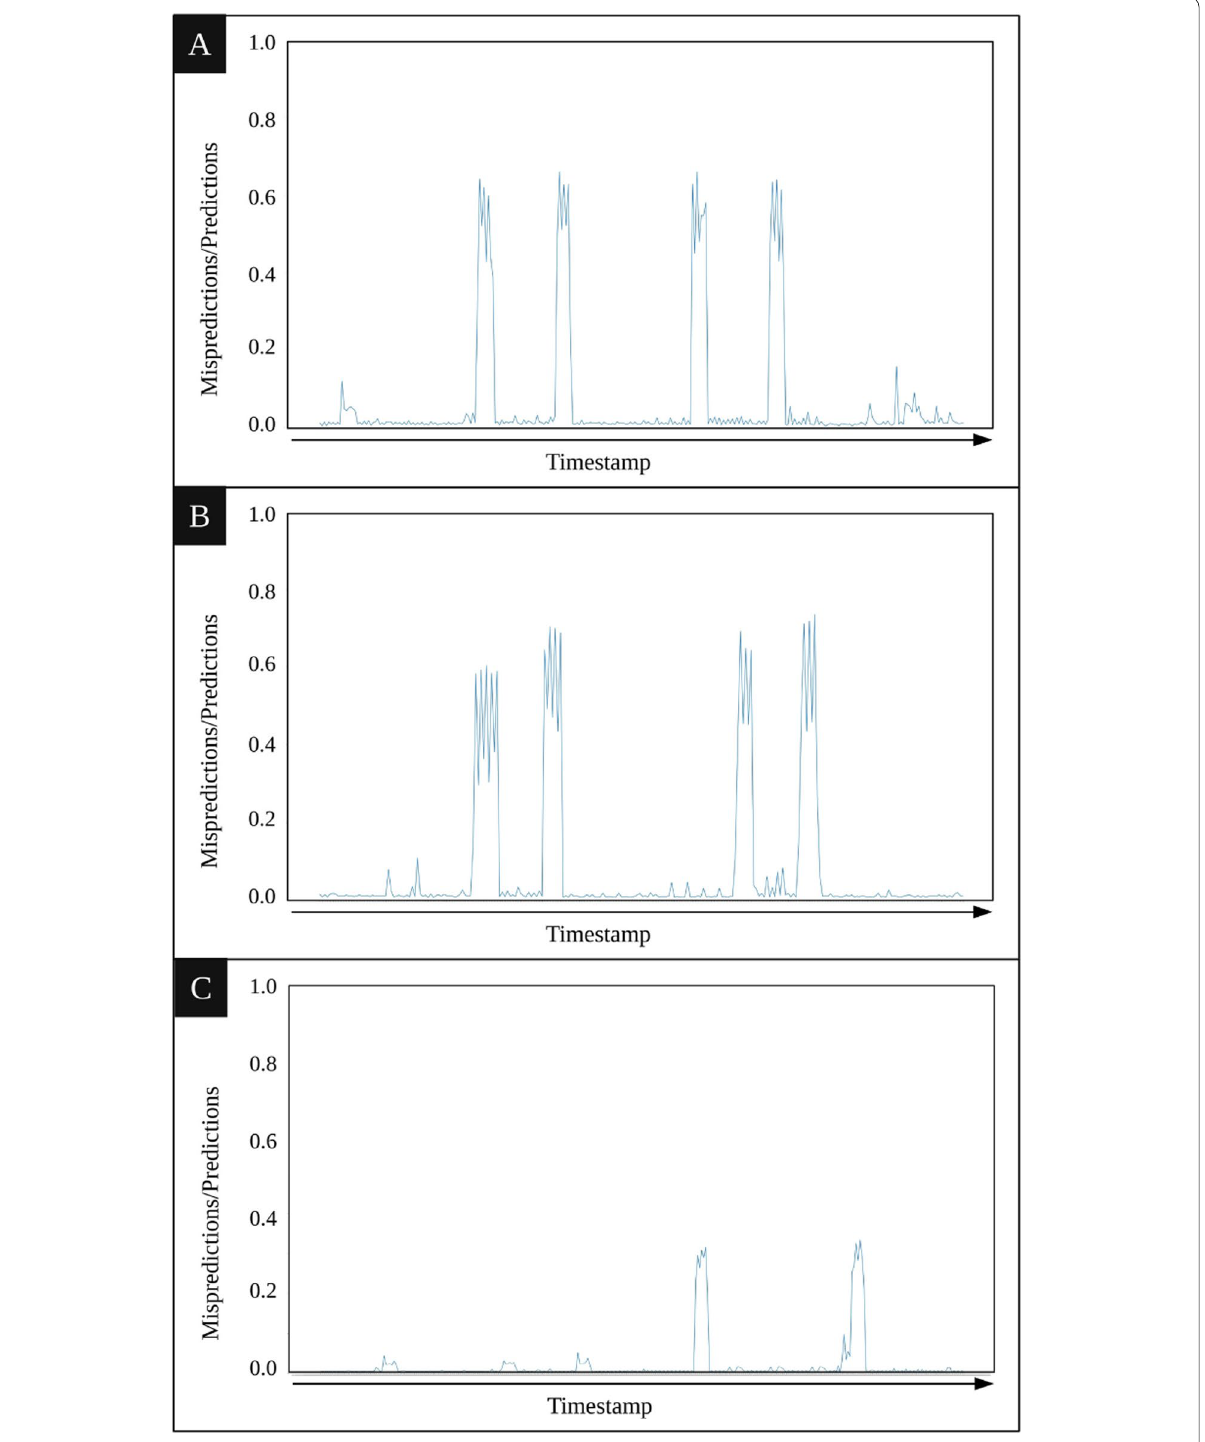
Fig. 8 This Figure depicts the Likelihood of detecting unexpected keys over the traces obtained from the three mentioned scenarios. A In this scenario, CPU-related anomalies were injected into the system. B In this scenario, disk-related anomalies were injected into the system. C In this scenario, a new release of the application without injecting anomaly was